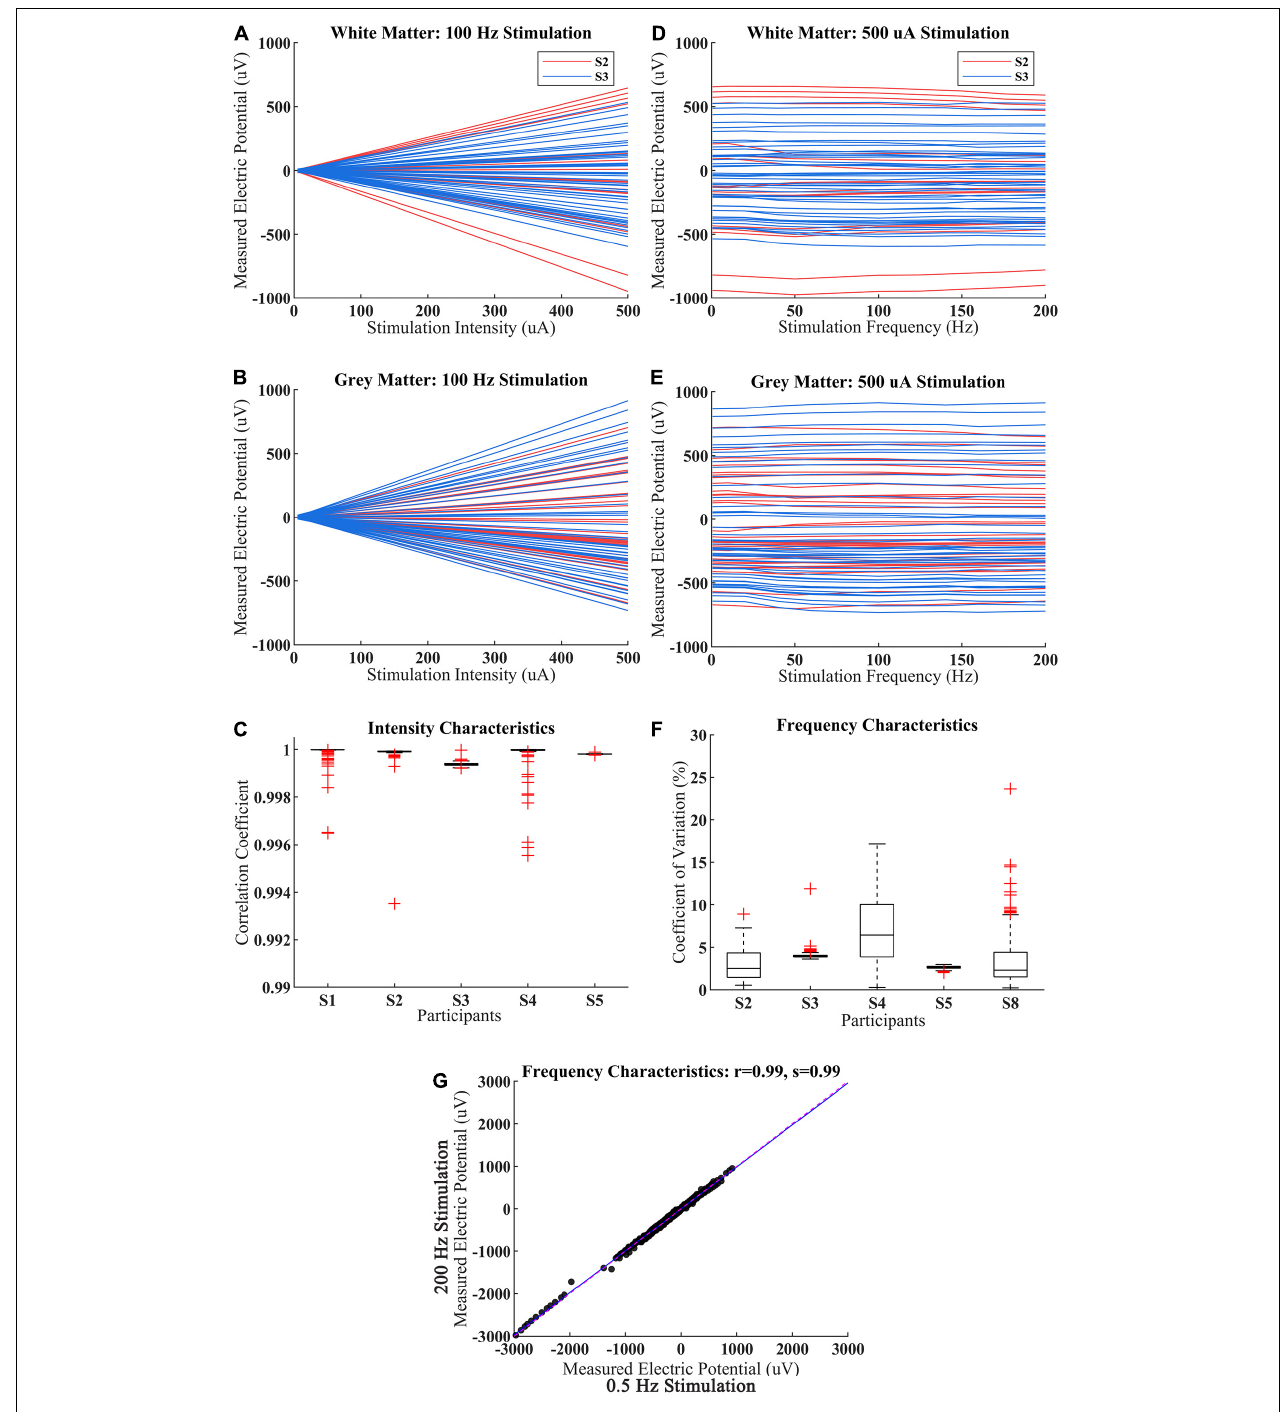
FIGURE 4 | Intracranial voltage recordings for various stimulation intensity and frequency. (A,B) The measured voltage with stimulation intensity increase from 5 to 500 µ A for the child (S2) and adult (S3) within WM and GM. Each red line represents a different electrode from S2, each blue line represents a different electrode from S3. (C) Under 100 Hz CES, the correlation coefficient of measured voltage with different stimulation intensity among participant S1–S5, the measured voltage derived from all sEEG electrode of each participant. (D,E) The measured voltage with stimulation frequency increase from 0.5 to 200 Hz for the child (S2) and adult (S3). Each red line represents a different electrode from S2, each blue line represents a different electrode from S3. (F) Under 0.5 mA CES, the coefficient of variation of measured voltages from different stimulation frequency among different participant S2–S5 and S8. (G) The measured voltage distributions between 0.5 and 200 Hz stimulation for participant S2–S5 and